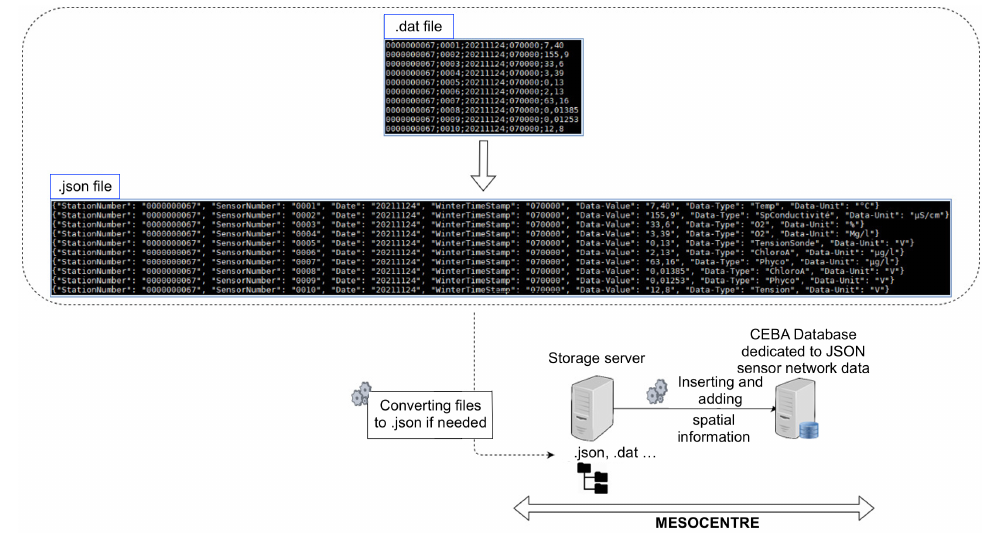
Figure 7. Converting and enrichment flow.